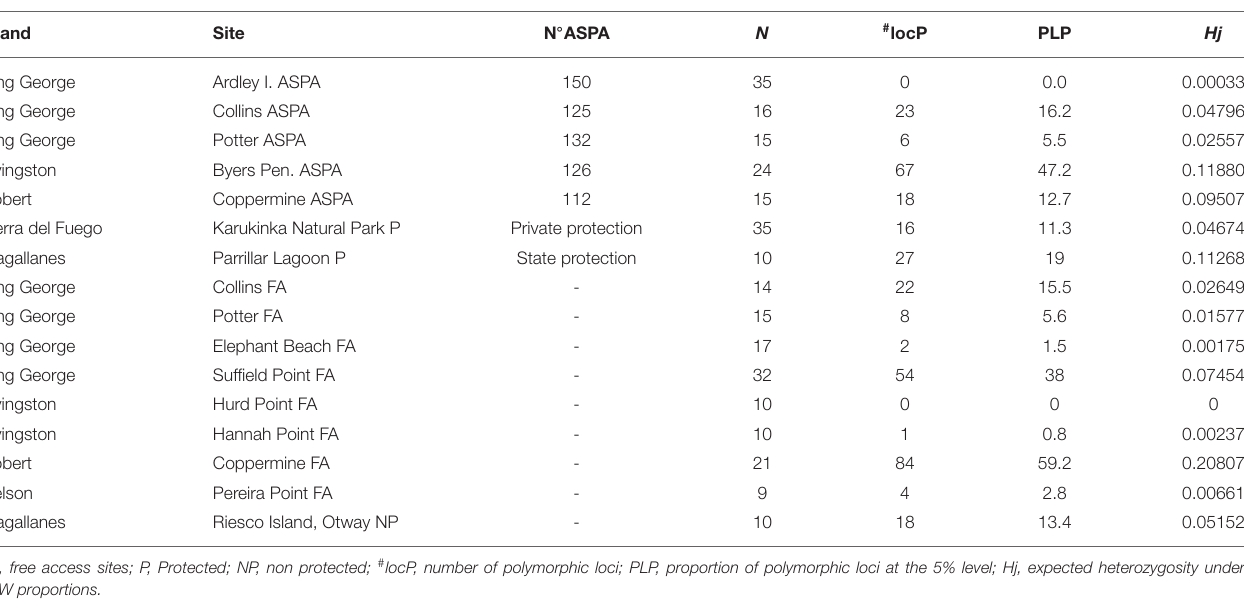
Frontiers in Conservation Science |